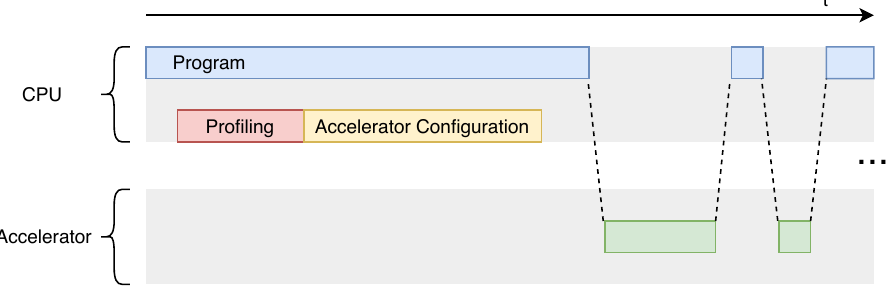
Figure 1. Transparent acceleration